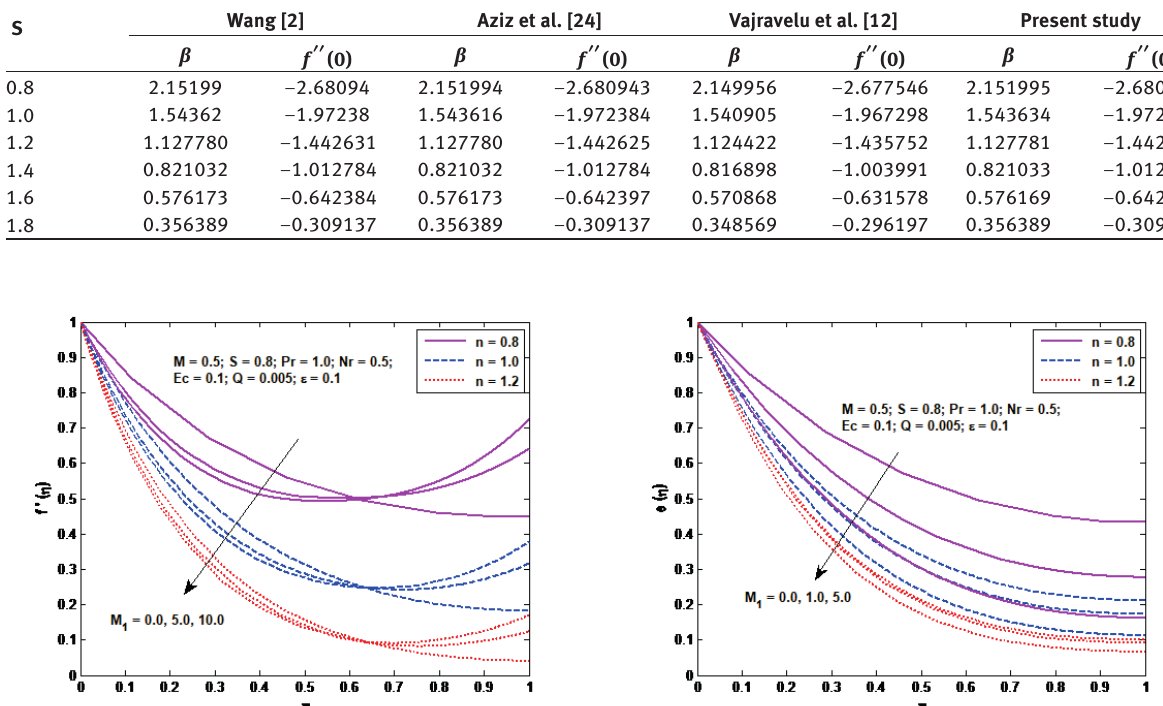
film, velocity increases gradually and ultimately assumes its free surface value. Thus thermocapillary force facili- tates an outward flow along the free surface. In the case of Newtonian and shear thickening fluids, though a similar trend of velocity is noticed, the observed variation for M 1 is not as significant as in shear thinning fluids. However, magnitude of velocity variation for M 1 in shear thicken- decreases from its prescribed value on the boundary and asymptotically attains its minimum value on film surface.